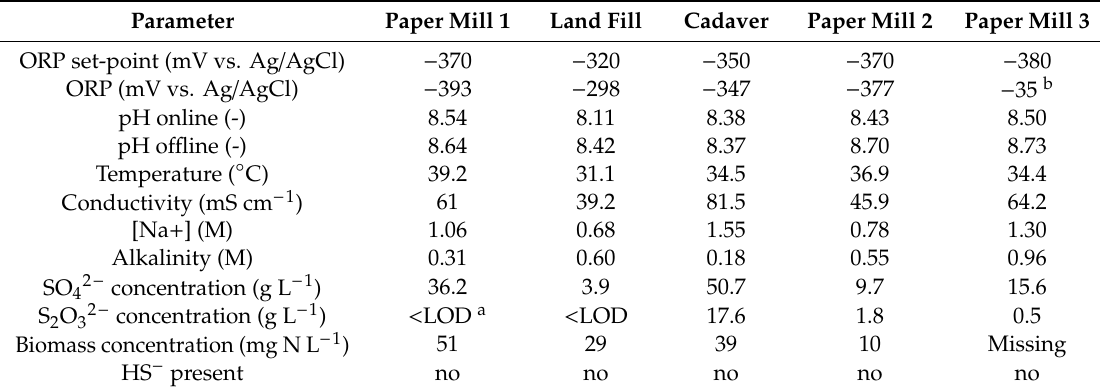
Table A2. Values for operational and chemical parameters for two of the five studied BD facilities.